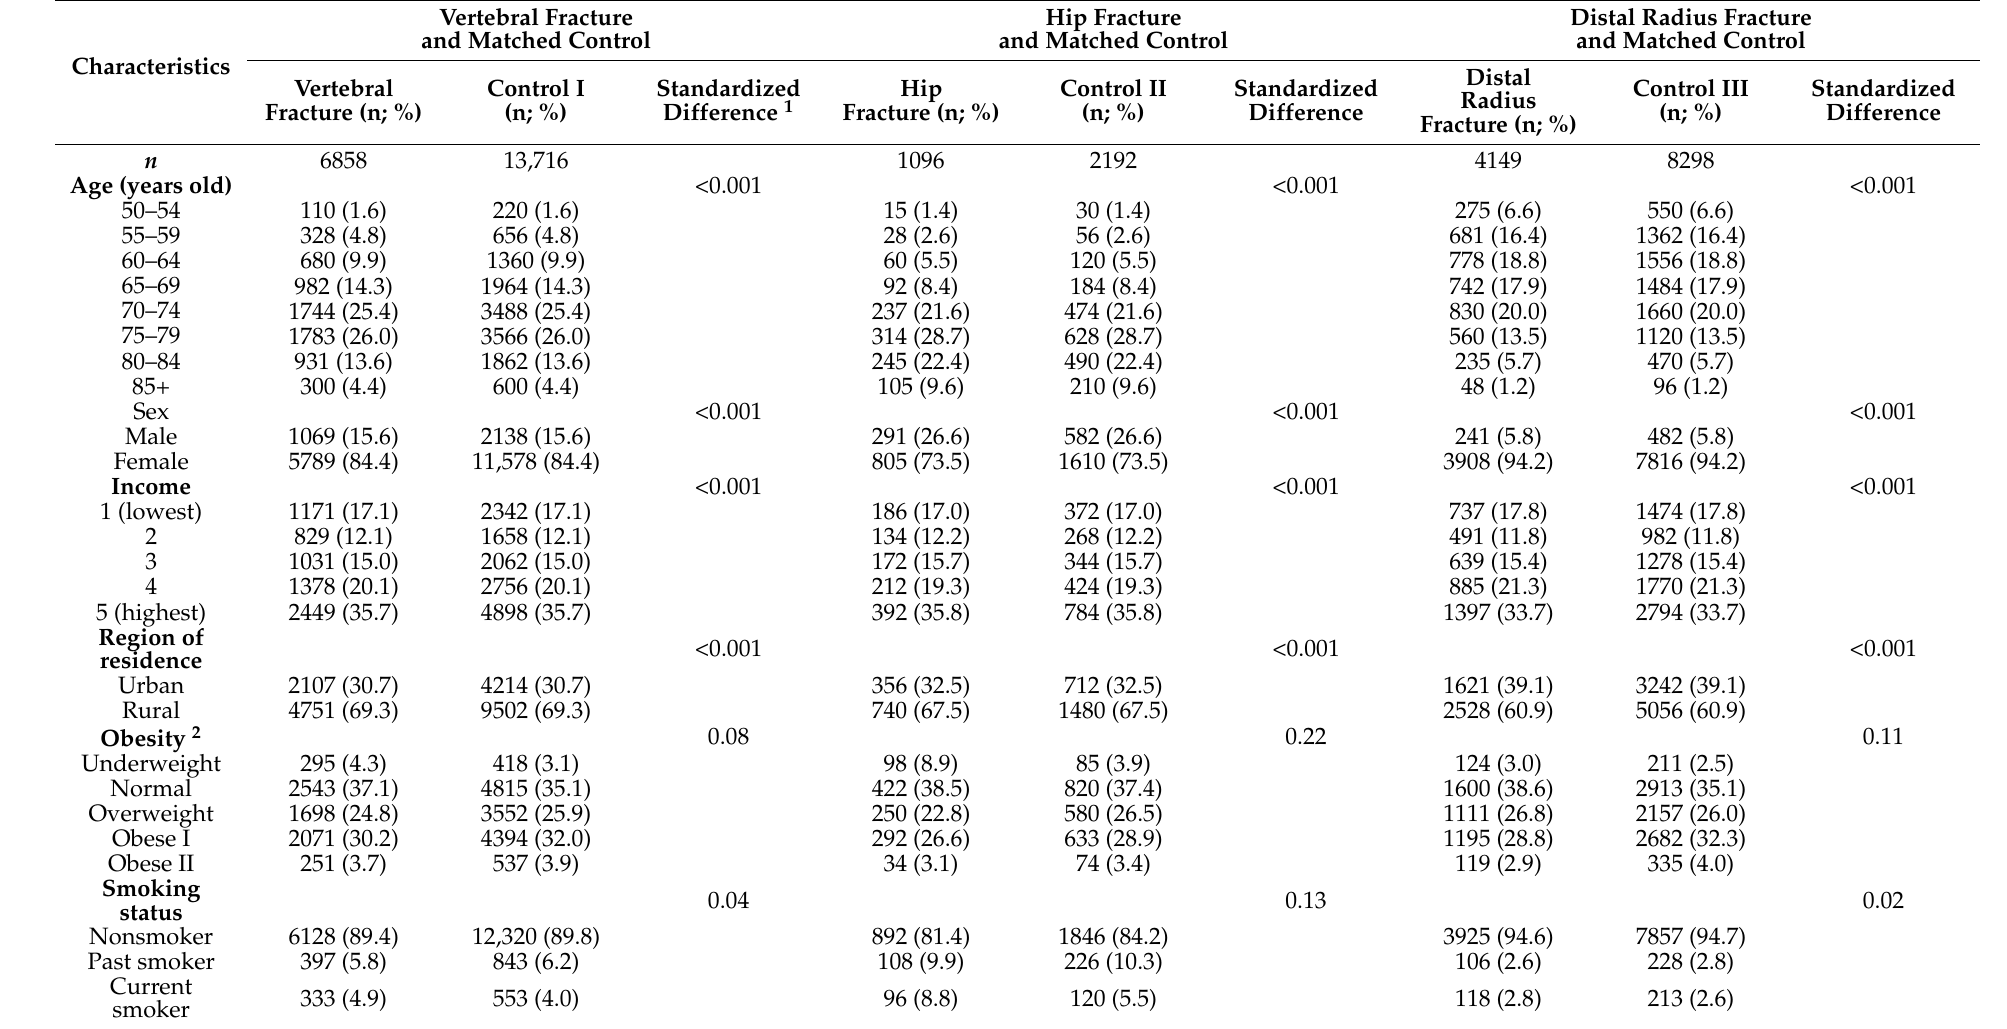
Table 1. General characteristics of